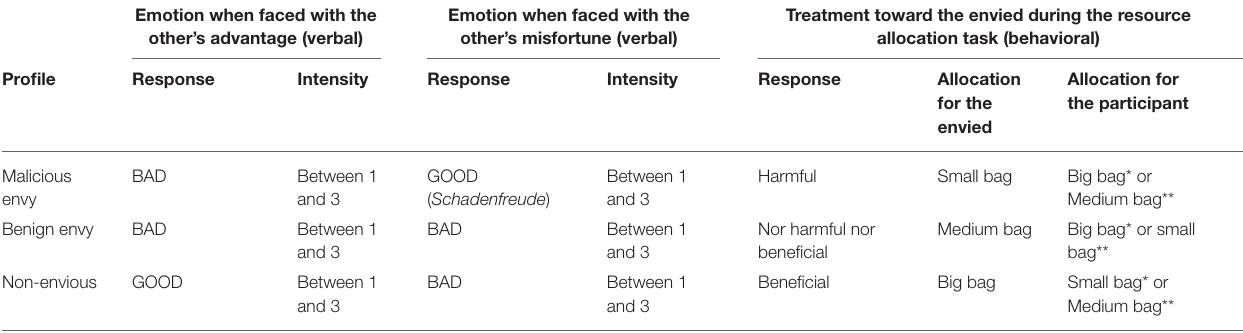
TABLE 1 | Definition of the envious and non-envious response profiles for verbal and behavioral responses. Emotion when faced with the other’s advantage